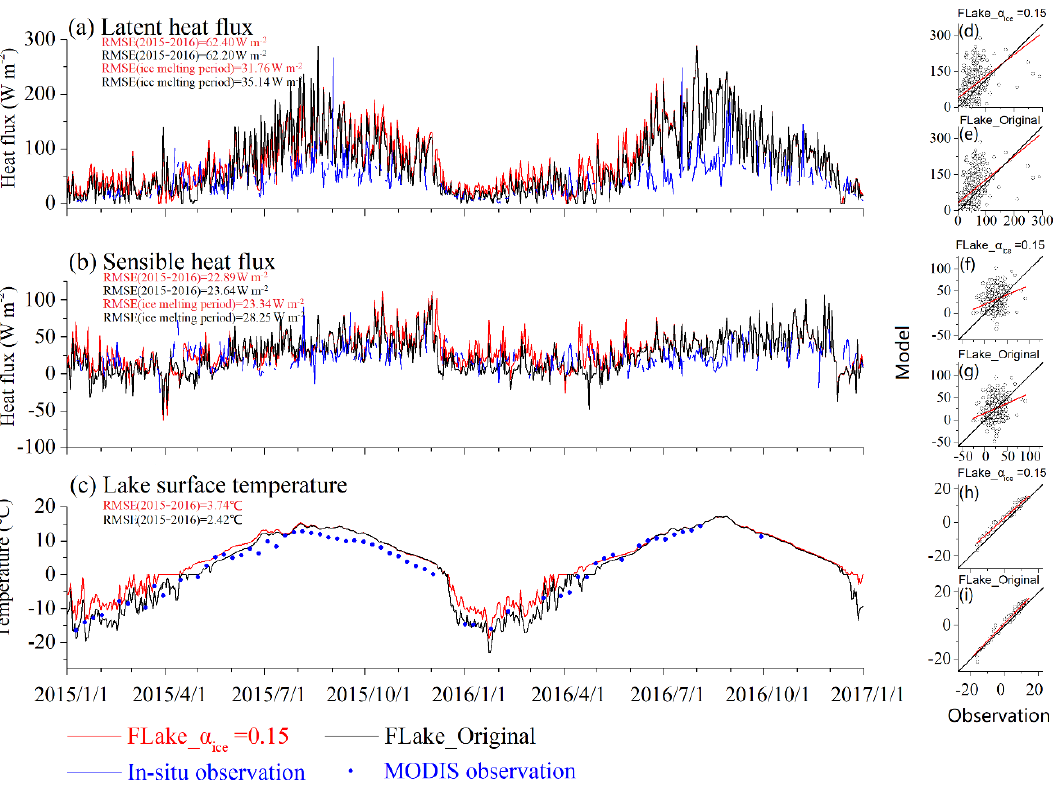
Figure 4. ( a – c ) Comparison and ( d – i ) evaluation of simulated LST, H and LE with in situ and MODIS observation data for Ngoring: ( a,d,e ) LE, ( b,f,g ) H, ( c , h , i ) LST. A fitted curve is shown for each variable, where the x represents the in situ observations and the y represents the simulated results. The comparison period is from January 2015 to December